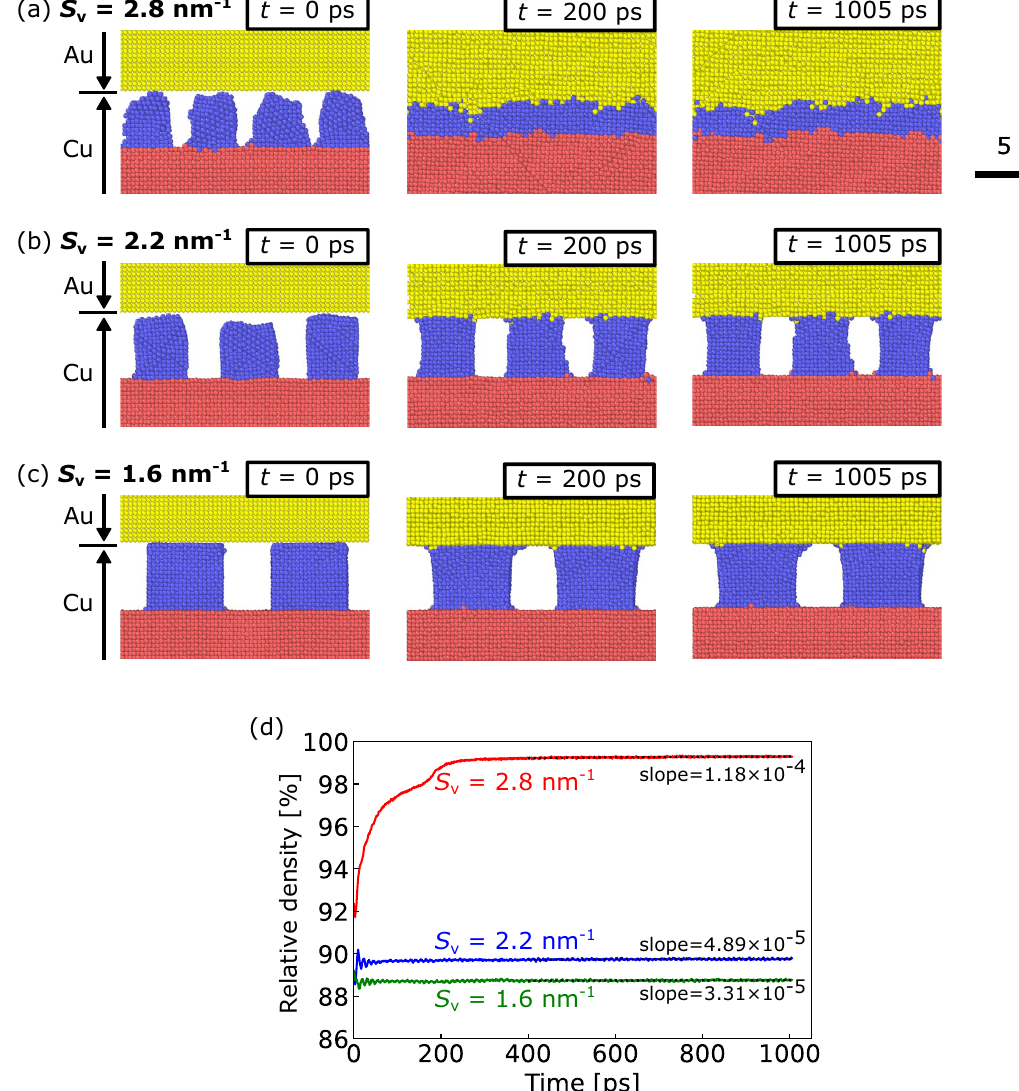
Figure 2. Evolution of the morphology of the surface nanostructure at the bonding interface. Cross-sectional configuration of the model with ( a ) S v = 2.8, ( b ) 2.2, and ( c ) 1.6 nm −1 at time steps of 0, 200, and 1005 ps (only atoms near the interface are shown). Cu atoms in the Cu slab, NS-Cu, and Au atoms in the Au slab are depicted in red, blue, and yellow, respectively. ( d ) Relative density as a function of the simulation time for S v = 2.8, 2.2, and 1.6 nm −1 . Relative density evolution at S v = 2.8 nm −1 was divided into an early stage (< 300 ps) and a later stage (> 300 ps). Linearly-fitted lines with slopes were inserted after 400 ps.